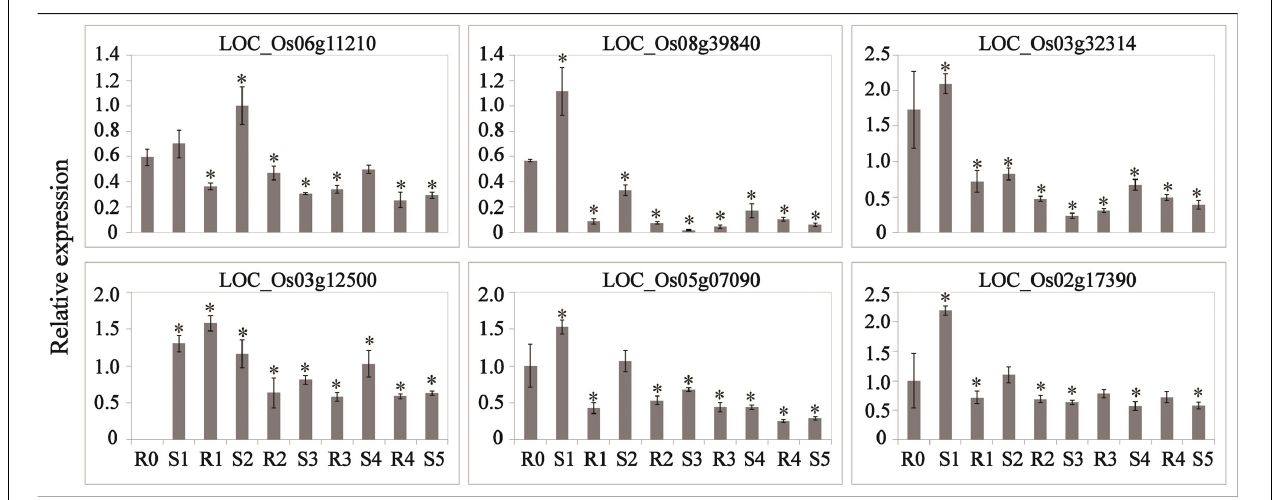
FIGURE 5 | Real-time quantitative PCR analysis for stress memory transcripts involved in the JA synthesis pathway during the drought stress cycles. EF-1 α (LOC_Os03g08020) was used as an internal control. Data are means of three biological replicates and error bars are ± SE from three independent experiments, each performed with 6–8 leaves from five separate plants. Asterisks indicate significant differences by Tukey LSD test ( ∗ P <